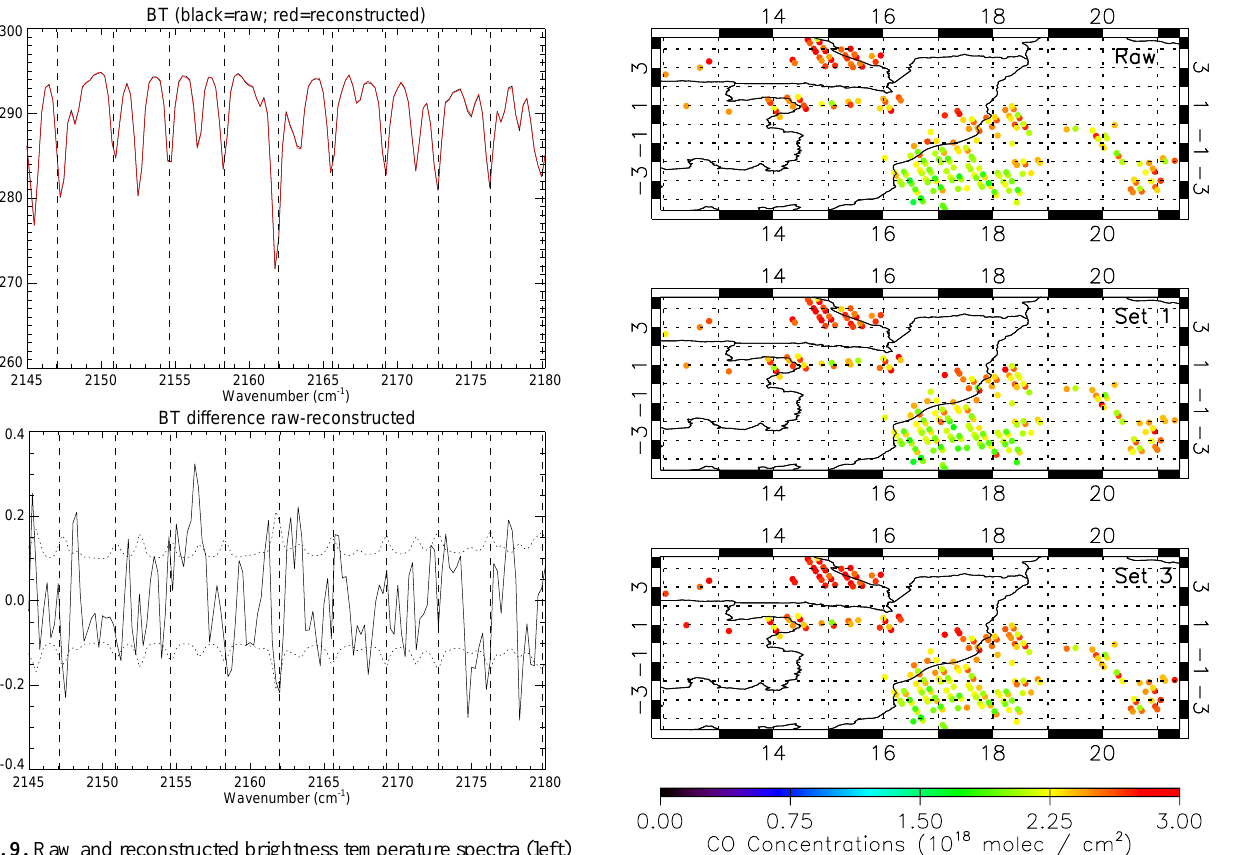
Fig. 10. Total column CO retrievals for 1 April 2008 over West Central Africa using (a) IASI raw radiances, (b) set 1 eigenvectors, (c) set 3